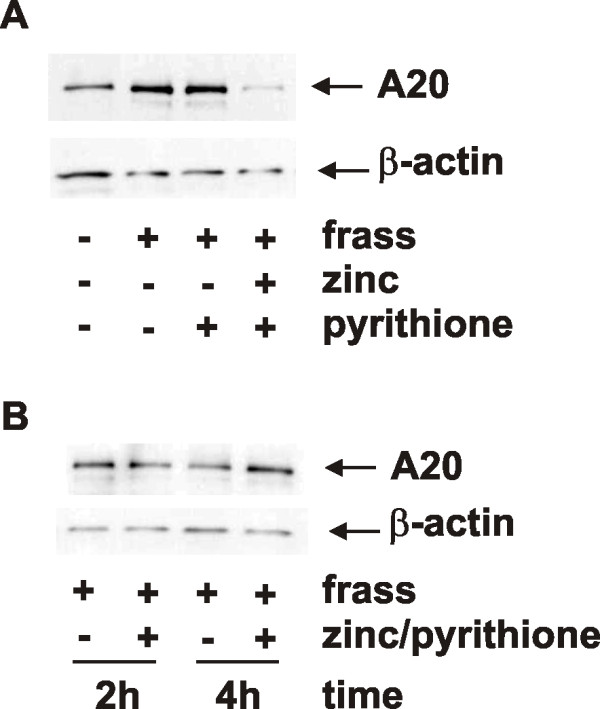
A20 protein levels following GC frass with or without zinc supplementation. HL-60 cells were treated with GC frass (1 μg/ml) or LPS (1 μg/ml) with or without zinc gluconate (1 μM) and pyrithione (10 μM) for 18 h (A) or for either 2 or 4 h (B). Cell lysates were harvested, separated by gel electrophoresis and probed with an antibody against A20 or β-actin. Each experiment was performed 3 times.